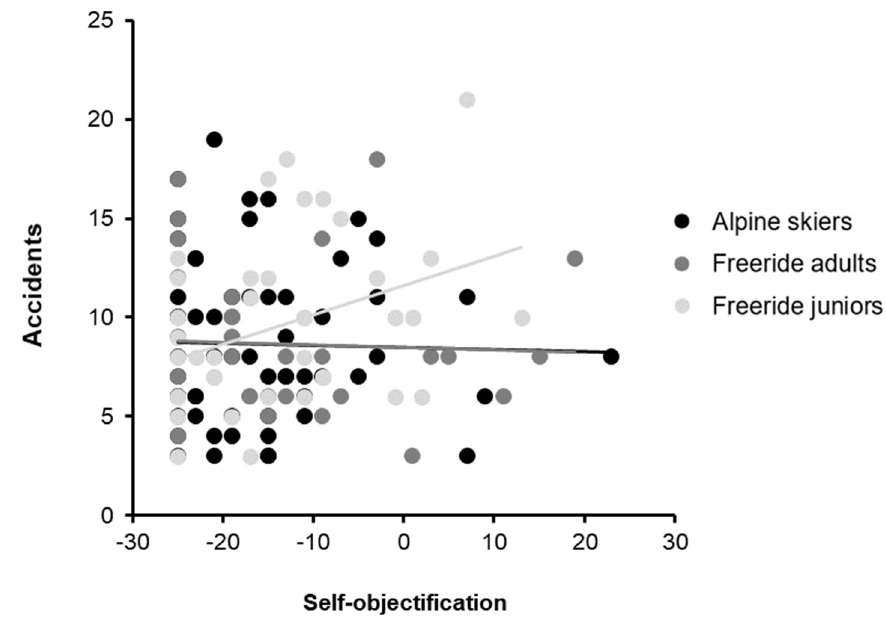
Figure 1. Group differences in the relation between self-objectification and accidents. The dots indicate values of each participant, the lines indicate the regression lines for each group.